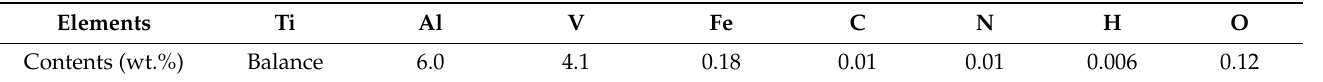
Table 1. The chemical composition of Ti-6Al-4V titanium